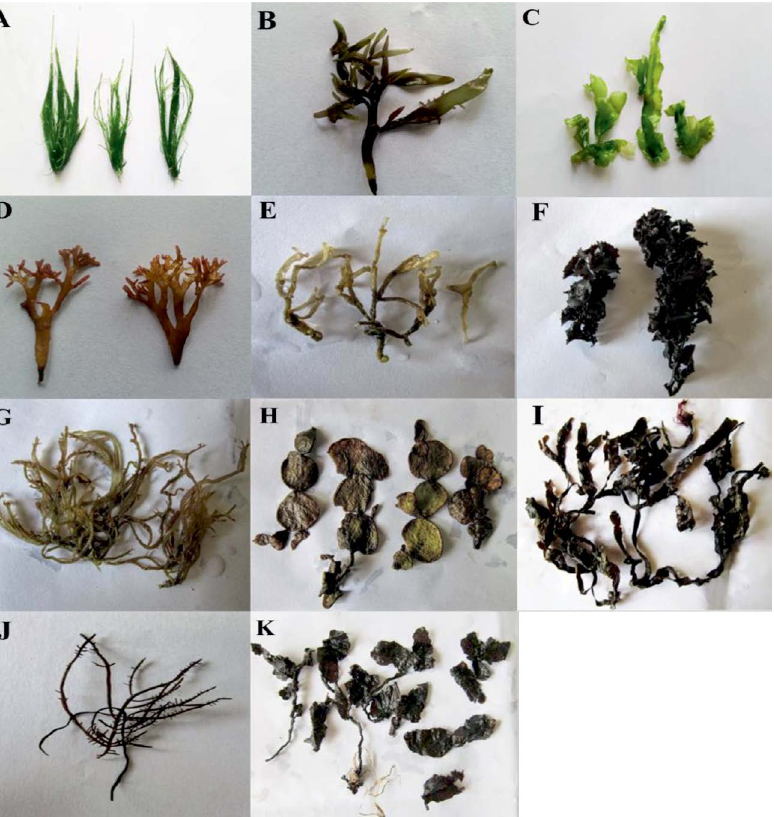
Fig. 1. (A) Chaetomorpha antenina . (B) Grateloupia lithophila . (C) Ulva lactuca . (D) Garcilaria corticata . (E) Garcilaria solicornia . (F) Turbinaria conides . (G) Gercilaria edulis . (H) Halimedia macroloba . (I) Stoechospermum marignatum . (J) Gelidiella acerosa . (K) Sargassum swartzii